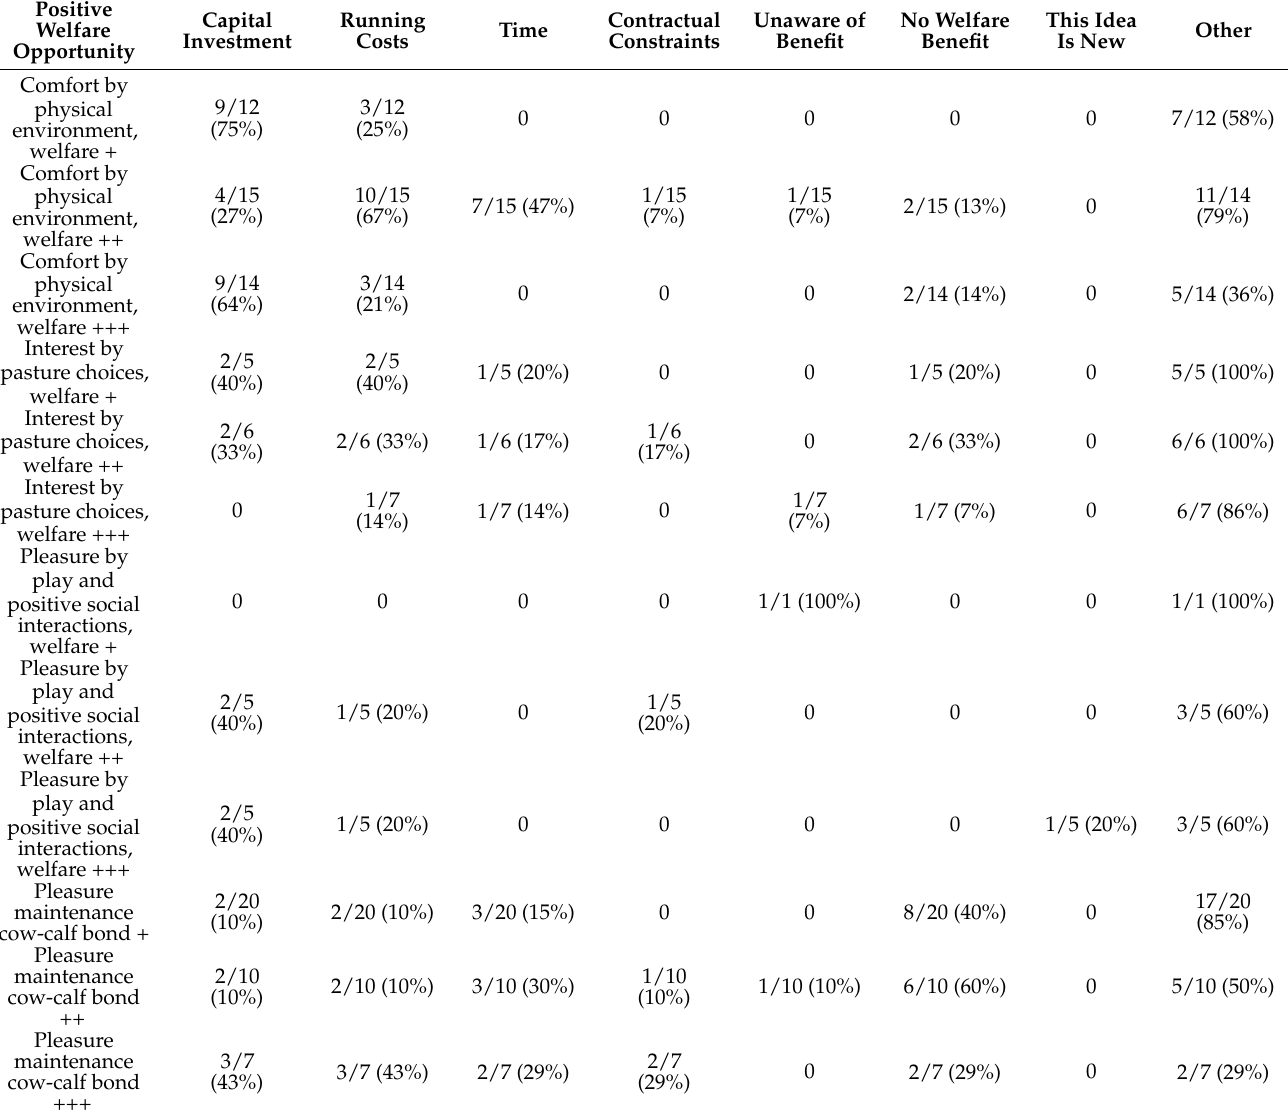
Table 4. Reasons reported by farmers for not achieving each welfare level for each positive wel- fare